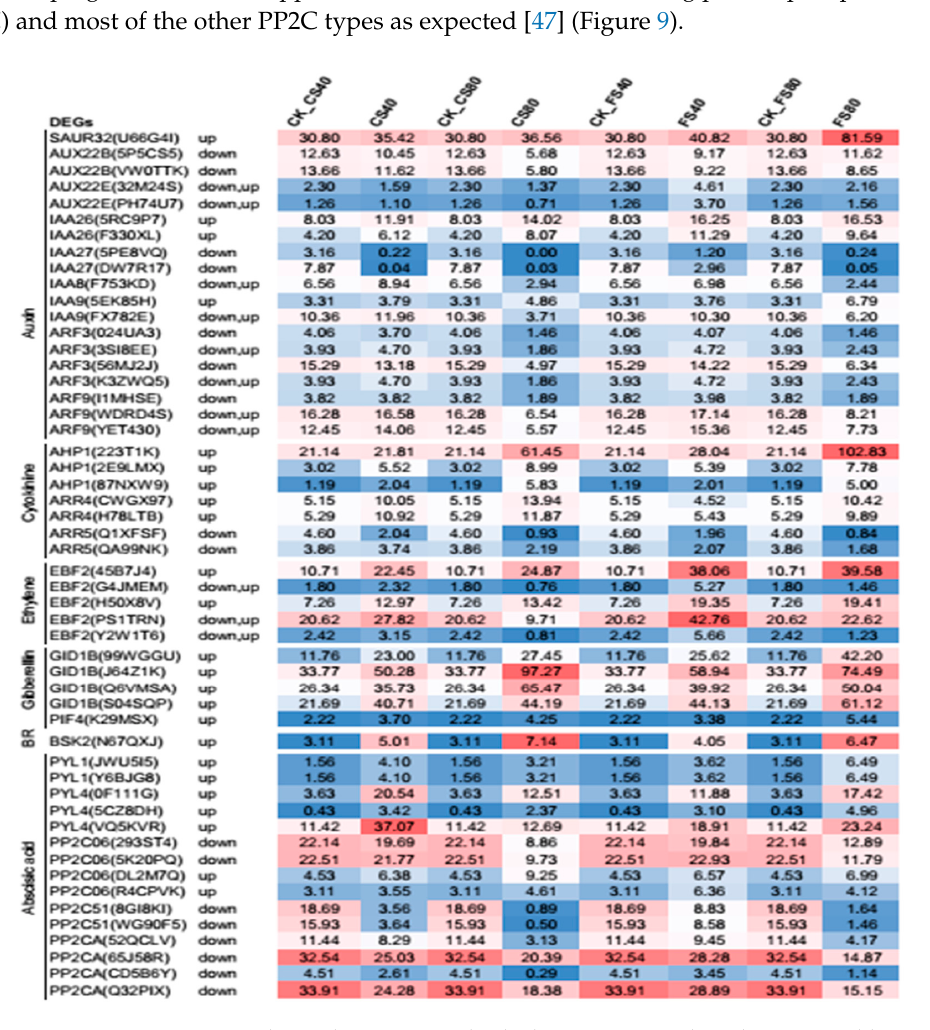
Figure 9. Gene expressional regulation in multiple hormone signal pathways. Abbreviates for DEG encoding proteins: SAUR, small auxin up RNAs like protein, AUX, auxin influx carrier; IAA, auxin- responsive protein IAA; ARF, auxin response factor; AHP, histidine-containing phosphotransferase; A-ARR, two-component response regulator ARR-A family; PYL, abscisic acid receptor PYL family; PP2C, protein phosphatase 2C; EBF, ethylene EIN3-binding F-box protein 2; GID1, gibberellin receptor GID1; PIF, phytochrome interacting factor 4; BR, brassinosteroids, BSK, brassinosteroid signaling kinase; Expression data represent the mean value of fragment per kilo base pair per million reads from three replicates, each with three biological plants at each treatment and corresponding control.